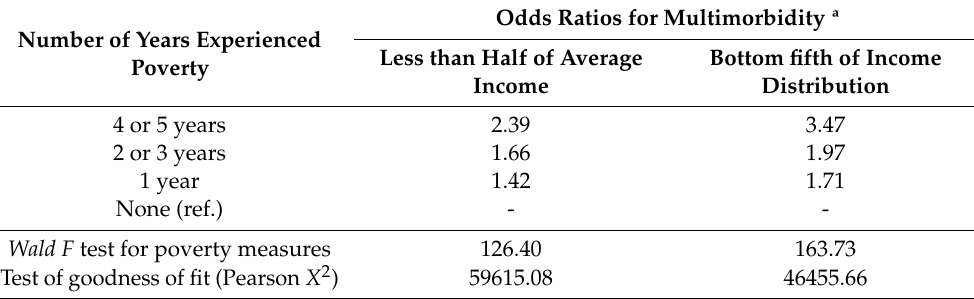
Table 4. Poverty duration and